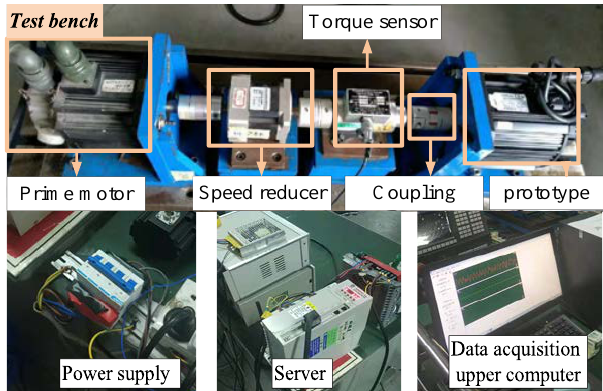
Figure 18. Test setup for the cogging torque of the prototypes.